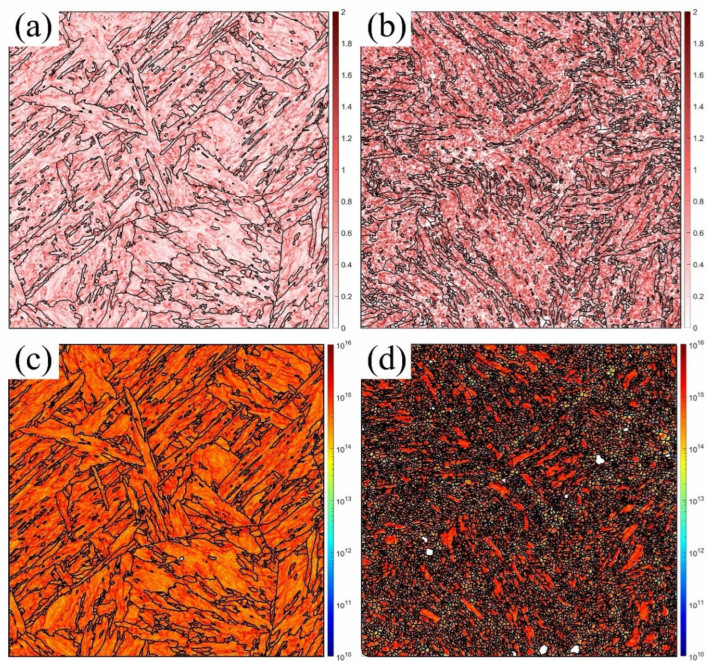
Figure 10. KAM and GND maps for the medium ( a , c ) and maximum ( b , d ) degrees of deformation at 430 ◦